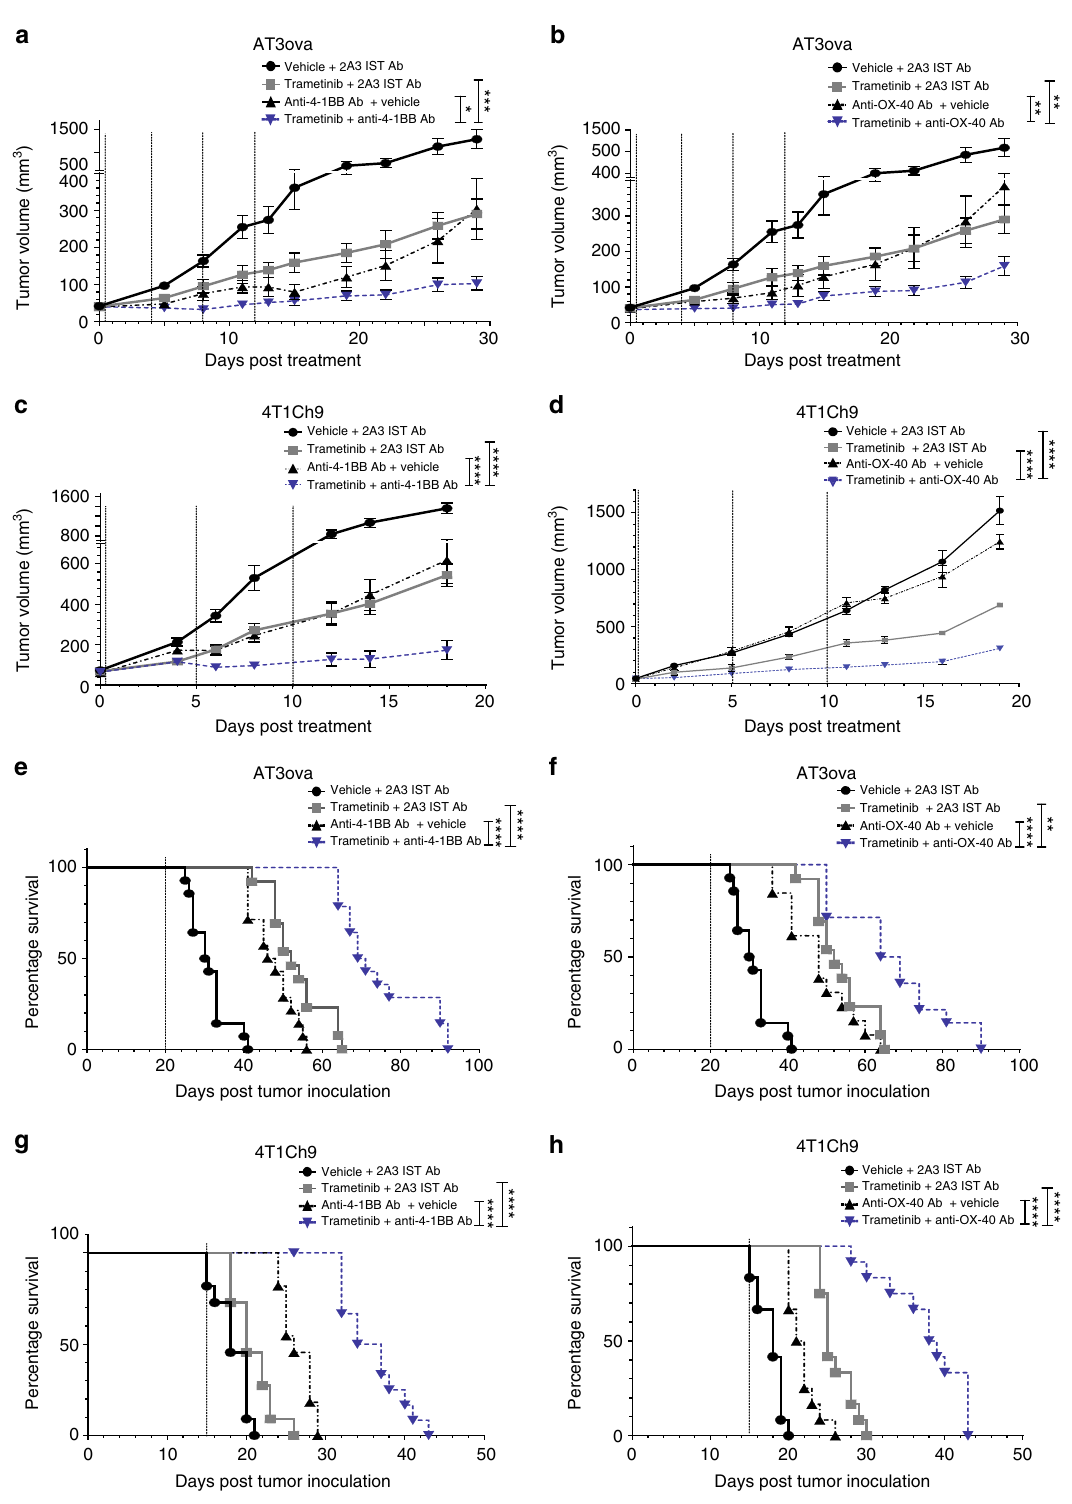
Fig. 6 Combined MEK inhibition and agonist immunotherapy leads to enhanced ef fi cacy of treatment against established TNBCs. Mice ( n = 6 per group) bearing established AT3ova a , b , e , f or 4T1Ch9 c , d , g , h tumors were treated with vehicle or trametinib via daily oral gavage for 20 days (AT3ova) or 15 days (4T1Ch9) and either 2A3 isotype control, α -4-1BB, or α -OX-40 antibody alone; three doses (4T1Ch9) or four doses (AT3ova) via IP injection on days 0, 4, 8, and 12 or combination of trametinib and agonists. a – d Tumor growth volume (mm 3 ) and e – h survival ( n = 12) were monitored. End point was determined as when tumors reached an ethical limit of 1400 mm 3 . Experiments are a representative of n = 2 – 3 replicates, with pooled mouse numbers for survival (mean tumor volume ± SEM). Controls groups are duplicated between panels as these experiments were performed concurrently. P -values represent two-way ANOVA, post hoc Tuckey ’ s tests for tumor growth, and log ranked (Mantel – Cox) test for survival proportions. * P < 0.05, ** P < 0.01, *** P < 0.001, **** P <